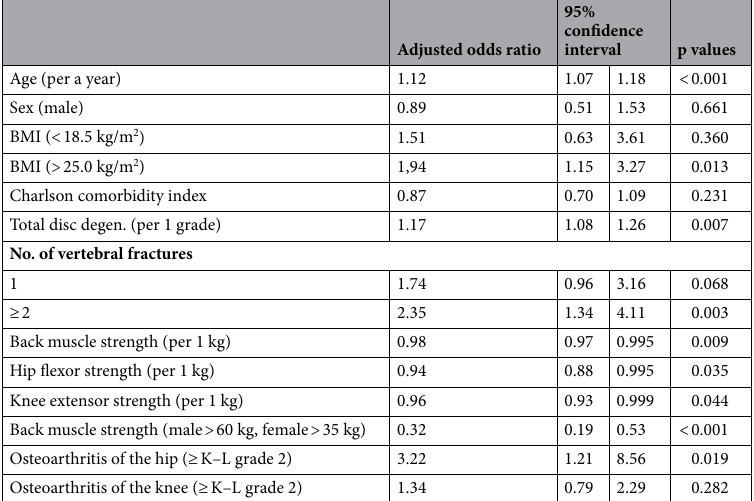
Table 2. Odds ratios obtained using the multivariate proportional odds model for the deterioration of sagittal vertical axis. This model was adjusted for age, sex, body mass index, the total disc degeneration, back muscle strength (per 1 kg) or back muscle strength (> 60 kg in men, > 35 kg in women), hip flexor strength (per 1 kg), knee extensor strength (per 1 kg), and osteoarthritis of the hip and knee (≥ K–L grade